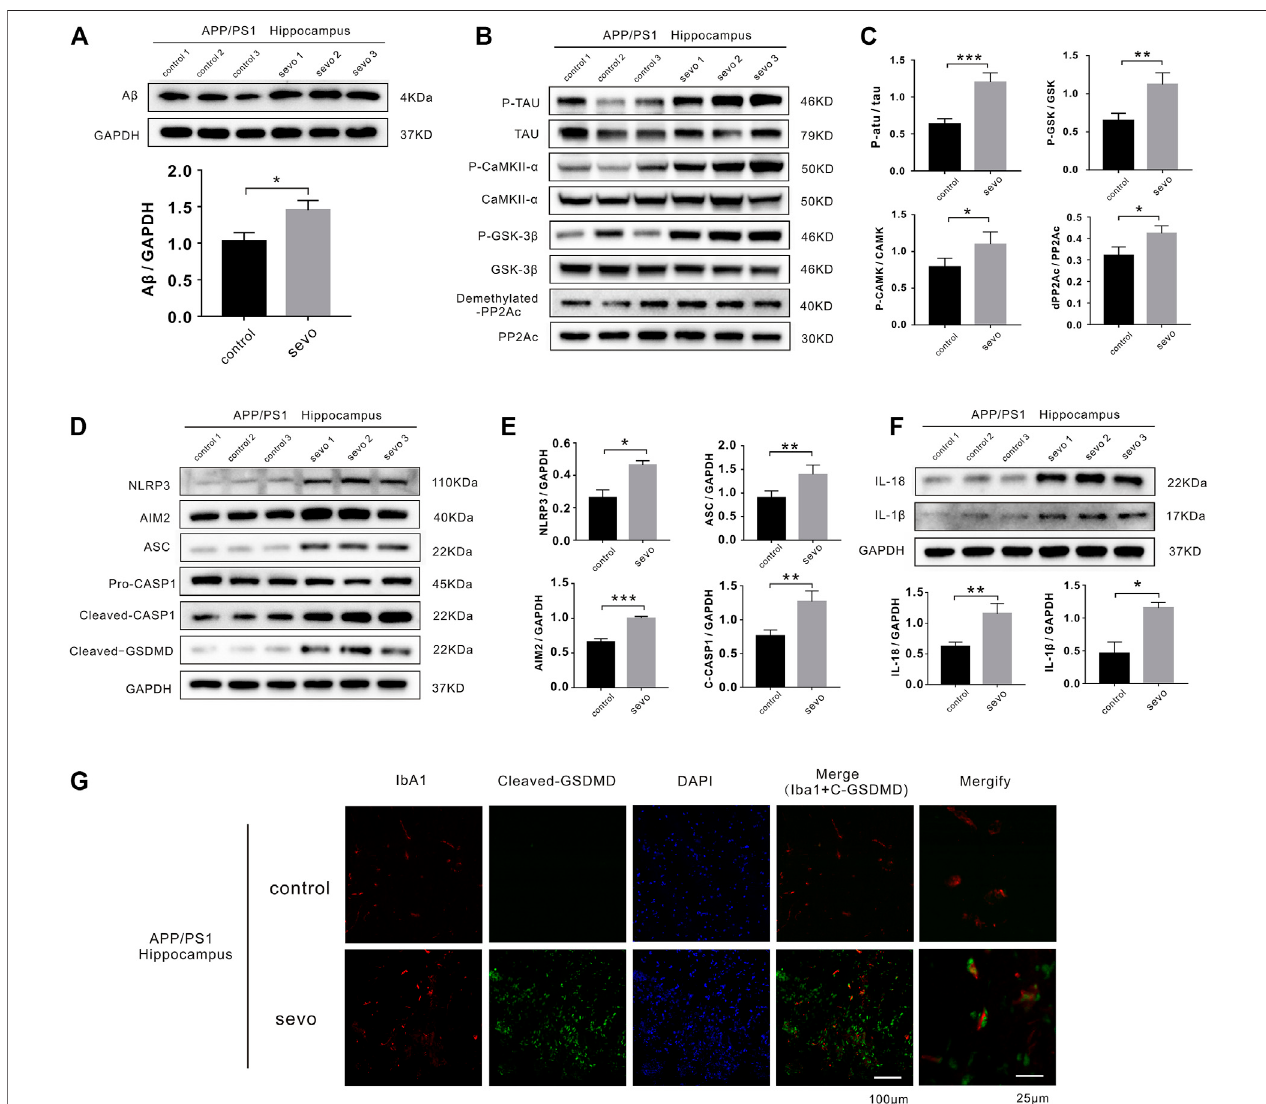
FIGURE 1 | Sevo fl urane induces pyroptosis and activates tau pathology in APP/PS1 mice. (A) Representative immunoblot analysis of A β protein expression in control or sevo fl urane-treated APP/PS1 mice using GAPDH as an internal control. (B) Immunoblot analysis of APP/PS1 mouse hippocampi stained for phosphorylated tau (p-tau), total tau, total PP2A subunit C, demethylated PP2A subunit C, p-CaMKII- α , total CaMKII- α , GSK-3 β phosphorylated (p-GSK-3 β ), and total GSK-3 β . (C) Quanti fi cation of kinases and phosphatases in B ( n (cid:1) 6). (D) Immunoblot analysis of NLRP3, AIM2, ASC, pro-caspase-1, cleaved caspase-1, and cleaved gasderminD (GSDMD). (E) Quanti fi cation ofproteins in Dusing GAPDHas aninternal control ( n (cid:1) 6). (F) Immunoblot analysis and quanti fi cation ofinterleukin-1 β and 18 inhippocampiaftersevo fl uranetreatment. (G) Immuno fl uorescencestainingofIba1,cleaved-GSDMD,andDAPI.Scalebar:100 μ m.*** p < 0.001,** p < 0.01,* p < 0.05.